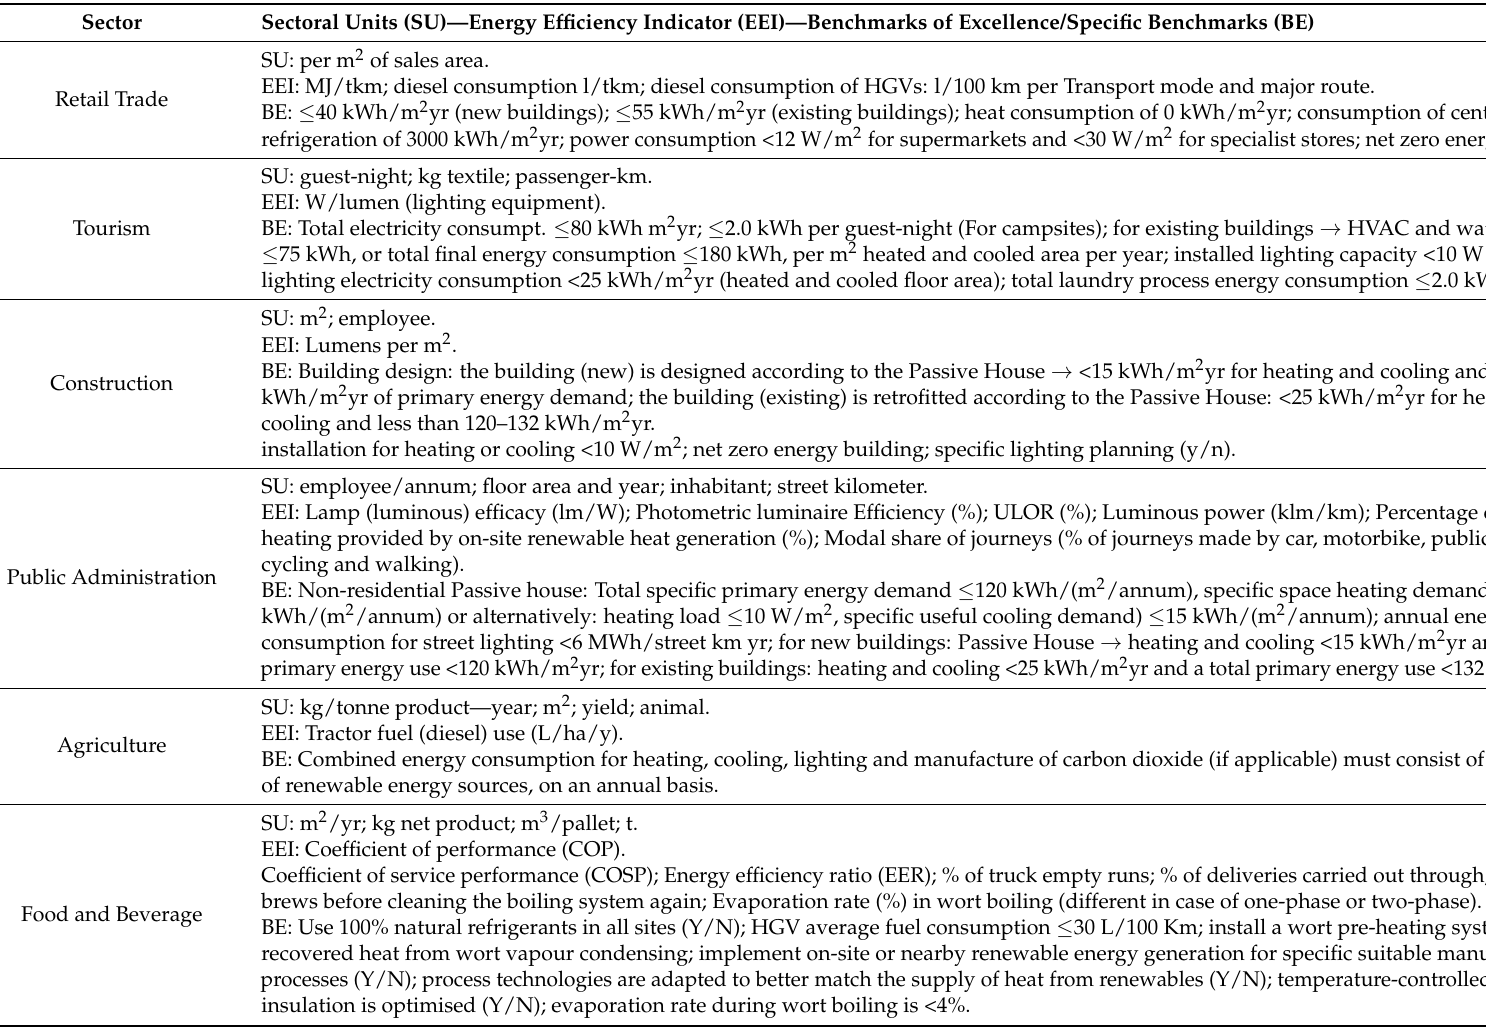
Table 3. Summarizes the main aspects related to Energy efficiency in the mentioned